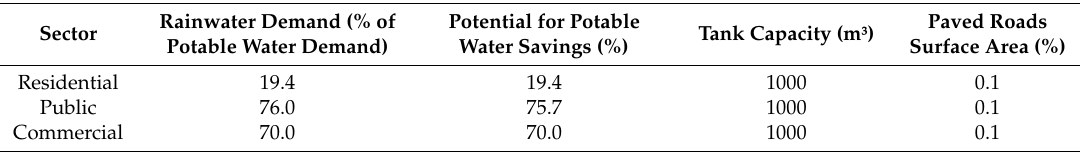
Summary of potential for potable water savings in the residential, public, and commercial